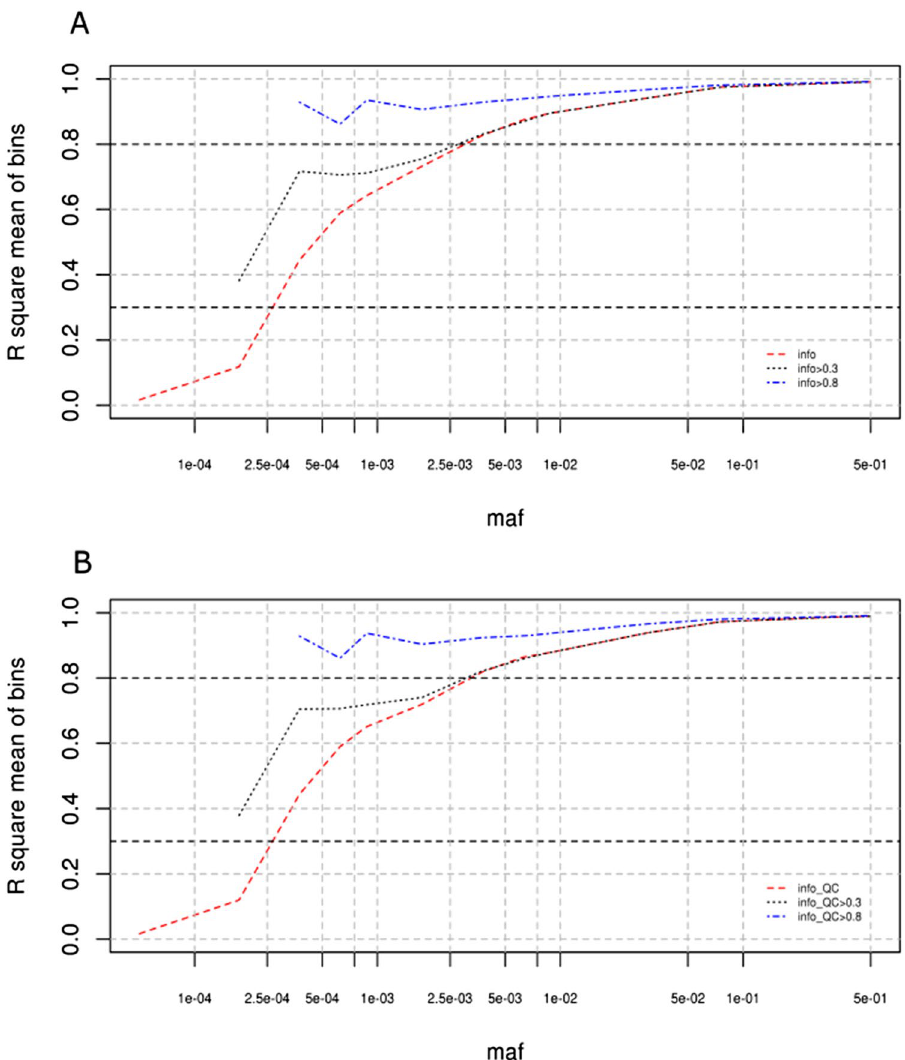
Figure 5. (a) Absence of QC: r-square (info-impute2 metric) mean of bins for variants according to the log(maf). Under 3 different post-filtration conditions (absence of post-filtration; post-filtration at an information score > 0.3; post-filtration at an information score > 0.8). Each middle bin is joined by a coloured dotted line. From 0.01 MAF, the information score tends towards the maximum information even in the absence of pre-filtration. (b) After QC pre-filtration: r-square (info metric) mean of bins for variants vs log(maf). Each middle bin is represented by a coloured dotted line (absence of post-filtration; post-filtration at an information score > 0.3; post-filtration at an information score >